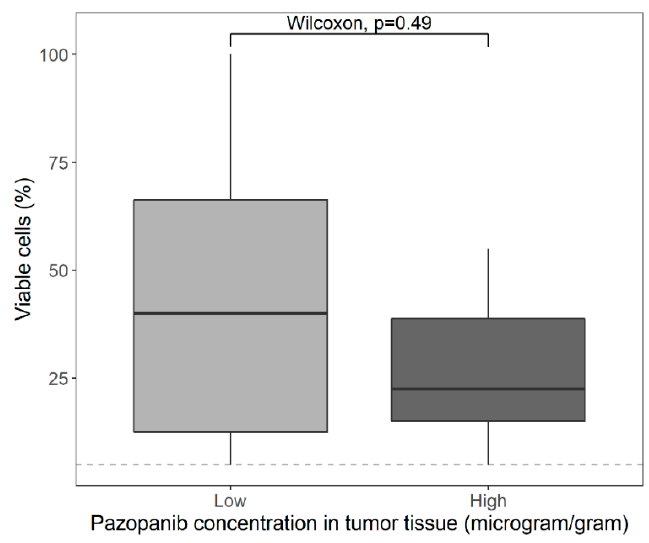
Figure 4: Pazopanib concentrations in tumor tissue, equally divided in two groups, versus percent- age of viable tumor cells in resection specimen. The dashed line represents the cut-off value for a good response, which is ≤ 5% viable tumor cells.